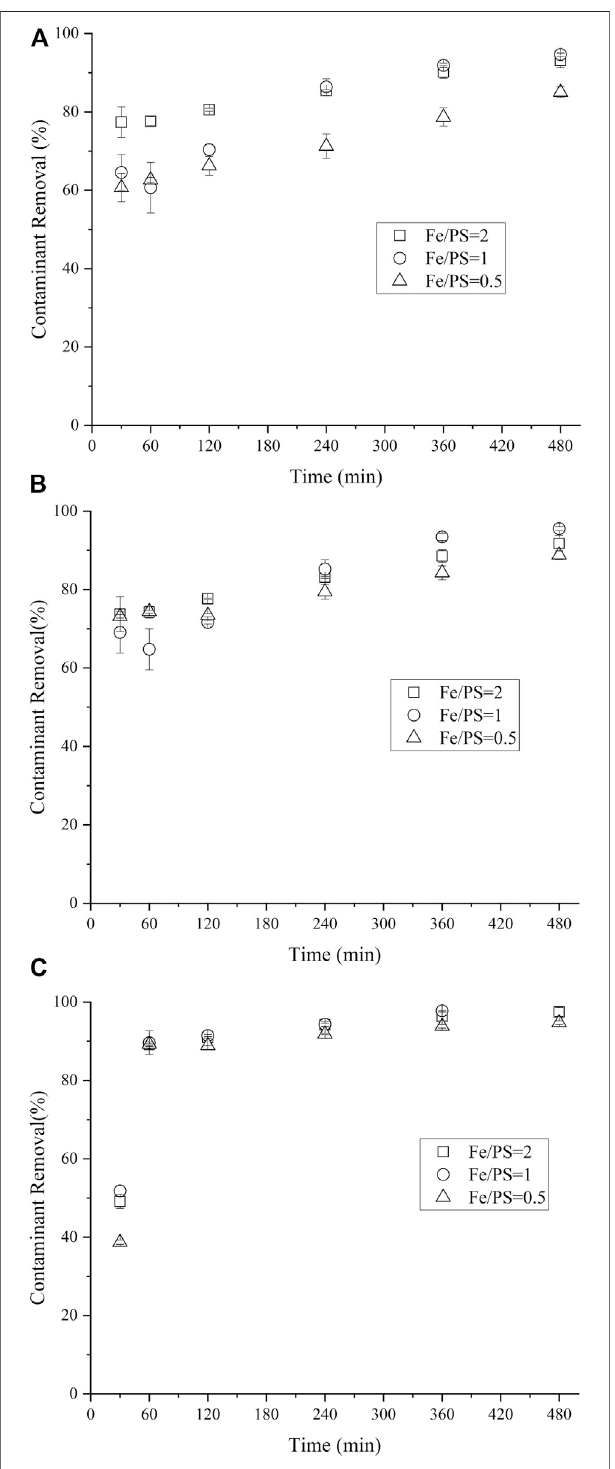
FIGURE 7 | Effect of m-NCB (A) , P-NCB (B) and o-NCB (C) initial concentrationontheirdegradation.ThenZVI/BCamount0.02 g,Fe/PSmolar ratio